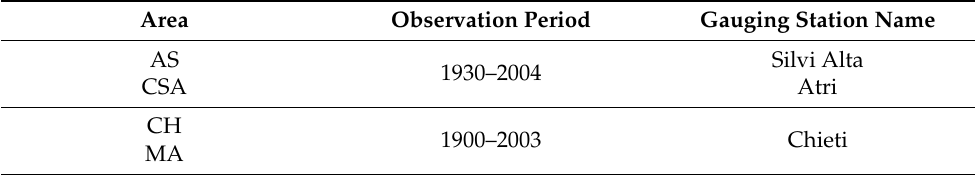
Table 1. Gauging stations (see Figure 1 for locations).